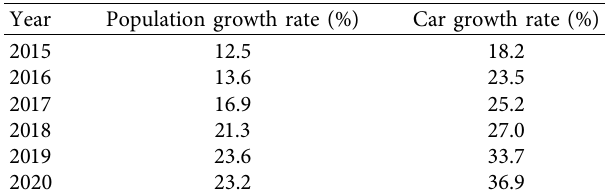
Table 1: Comparison table of 3 algorithms.